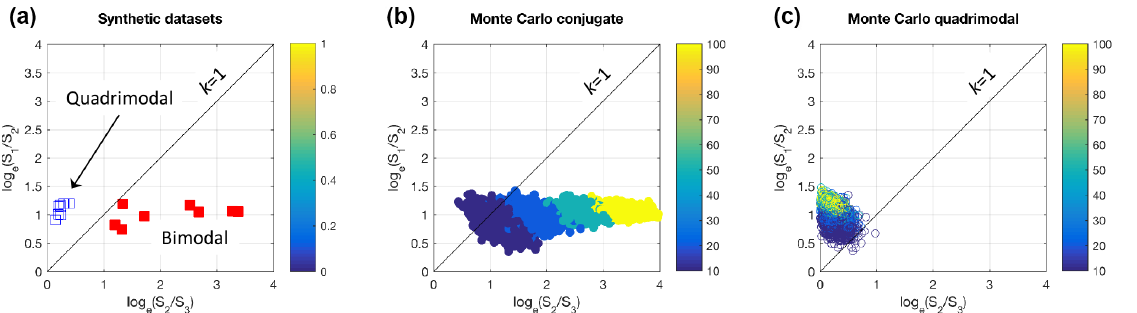
Figure 6. Graphs showing the ratios of eigenvalues of the orientation matrices for the synthetic datasets (Flinn, 1962; Ramsay, 1967; Woodcock, 1977). (a) Synthetic conjugate (i.e. bimodal; filled red symbols) and quadrimodal (hollow blue symbols) fault data. Note that the conjugate and quadrimodal data lie on either side of the line k = 1, where k = log e (S 1 /S 2 )/ log e (S 2 /S 3 ) . (b) Eigenvalue ratios from a Monte Carlo simulation of conjugate fault orientations using the two Watson mixture model; 1000 simulations were run for each of four different κ values (10, 20, 50 and 100; a total of 4000 data points) corresponding to the range of the discrete datasets shown in (a) . (c) Eigenvalue ratios from a Monte Carlo simulation of quadrimodal fault orientations using the four Watson mixture model; 1000 simulations were run for each of four different κ values (10, 20, 50 and 100; a total of 4000 data points) corresponding to the range of the discrete datasets shown in (a) .